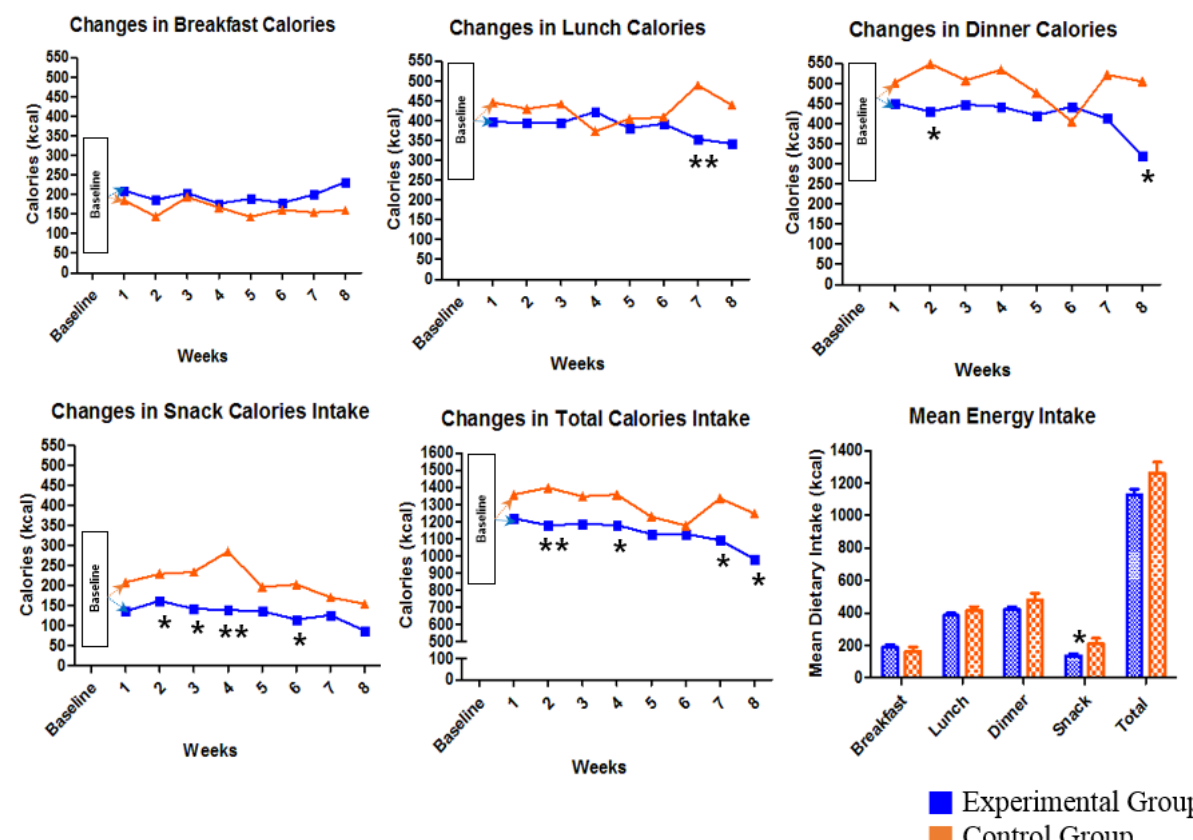
Figure 6. Changes in meal calories between experimental and control groups during the intervention period, as well as the contrast of mean energy intake between groups. * P <.05; ** P